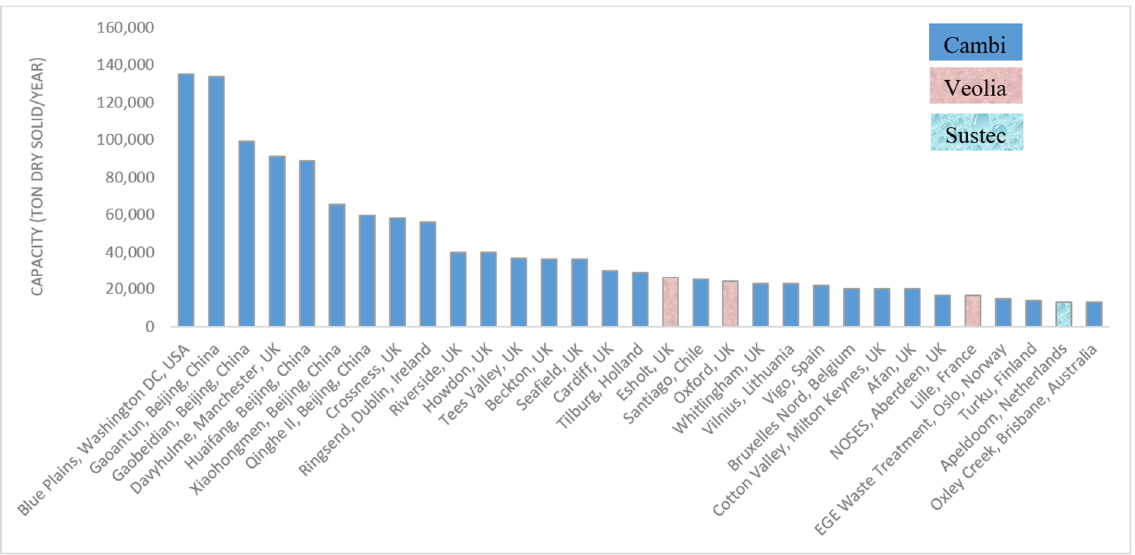
Figure 4. Largest full-scale thermal hydrolysis plants as of 2021 (Source: Adapted from companies’ websites).